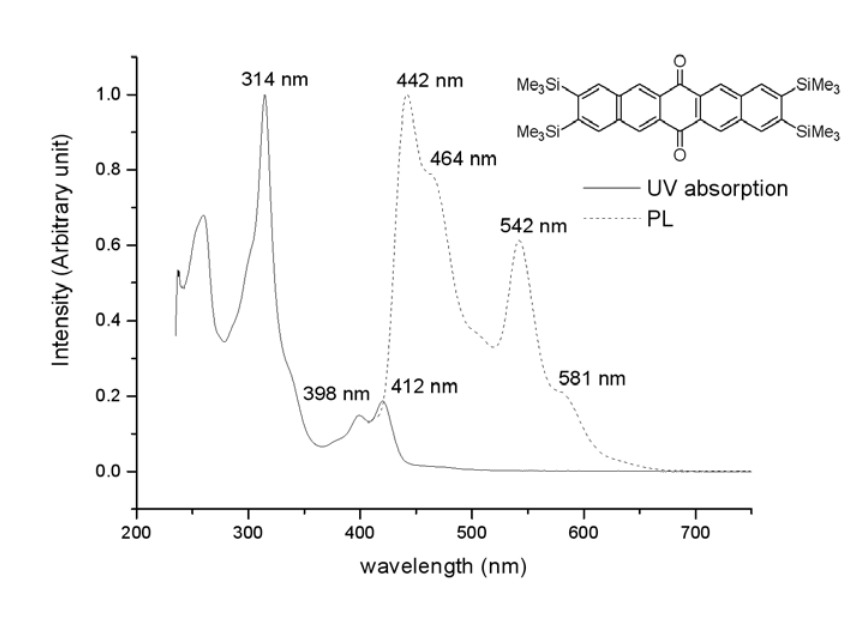
Fig. 4 The UV-VIS and PL spectra of compound 2